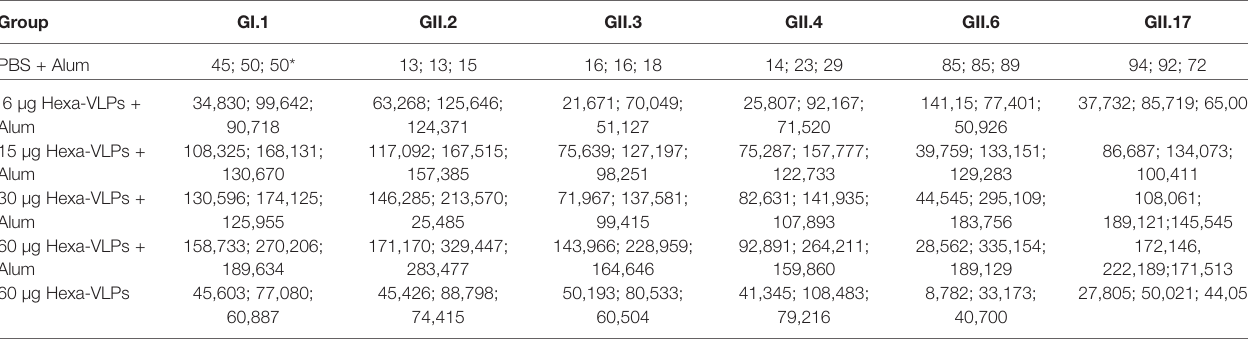
TABLE 1 | 4 w, 8 w and 12 w GMT enumeration of dose-escalation study. Group